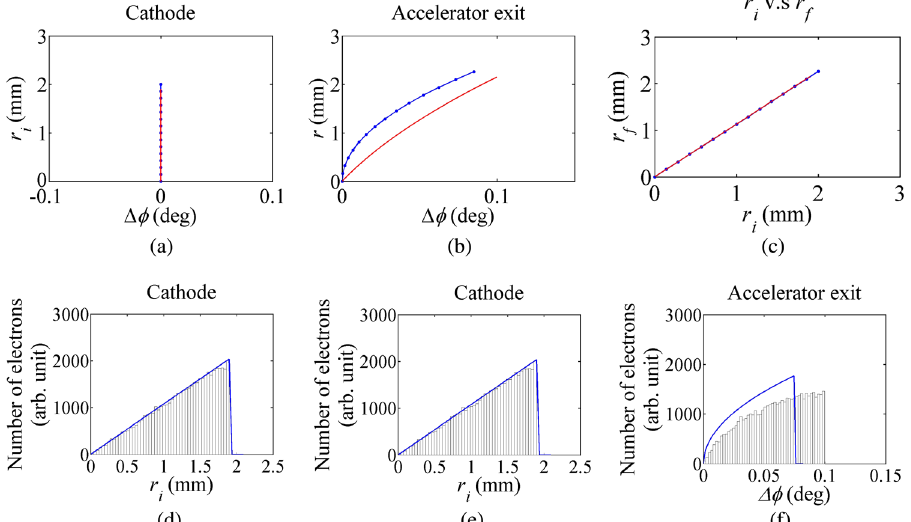
FIG. 4. (a) – (c) PARMELA simulation results (red lines) for a delta-function electron bunch before and after acceleration in the photoinjector, compared with our theoretical model (blue dotted lines). (a) Δ ϕ − r distributions of an ultrashort electron bunch injected at ϕ 0 ¼ 190 ° at the cathode and (b) at the accelerator exit. (c) Linear relationship between r i and r f of the electrons. (d) Radial distributions of electrons at the cathode and (e) at the accelerator exit. (f) Longitudinal distribution of electrons at the accelerator exit. The radial and longitudinal distributions of an electron bunch can be regarded as the projections of the bunch onto the radial and longitudinal directions, respectively. The blue lines in (d) – (f) are calculated from the distribution functions (13) – (15), compared with the histograms of PARMELA simulation